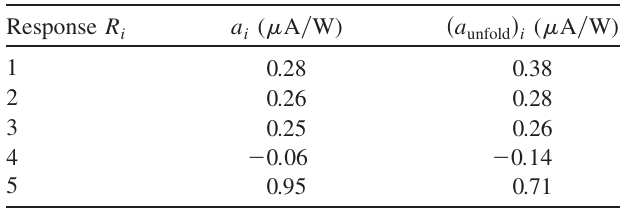
TABLE V. Comparison of coefficients for flux passband FIG. 11. Time-dependent simulations. Part (a) shows two pre- ð t Þ and T ð t Þ , with peak values scribed temperature histories, T 150 225 of 150 and 225 eV. Time-dependent Planckian spectra,